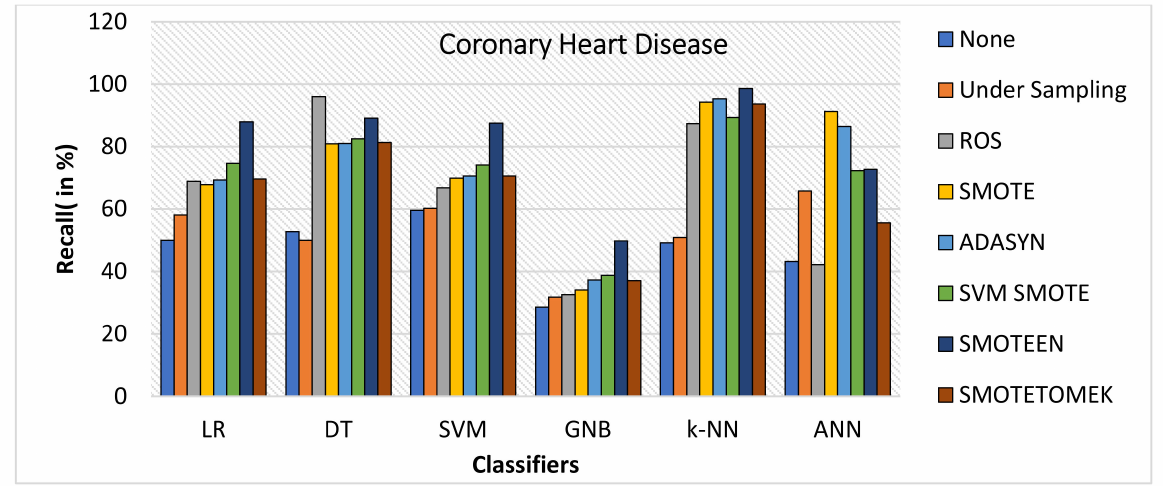
Figure 20. Recall for coronary heart disease dataset of balancing algorithms over six